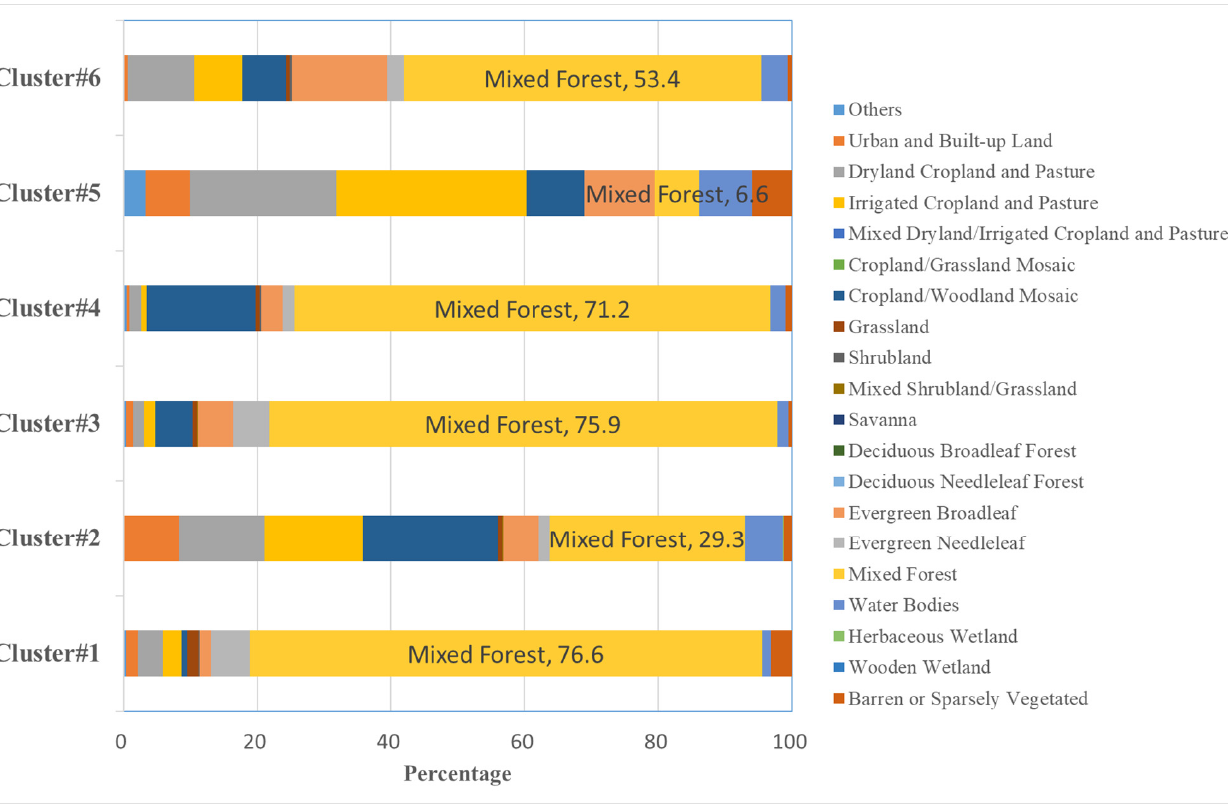
Figure A13. Percentage of land use classes for each cluster.